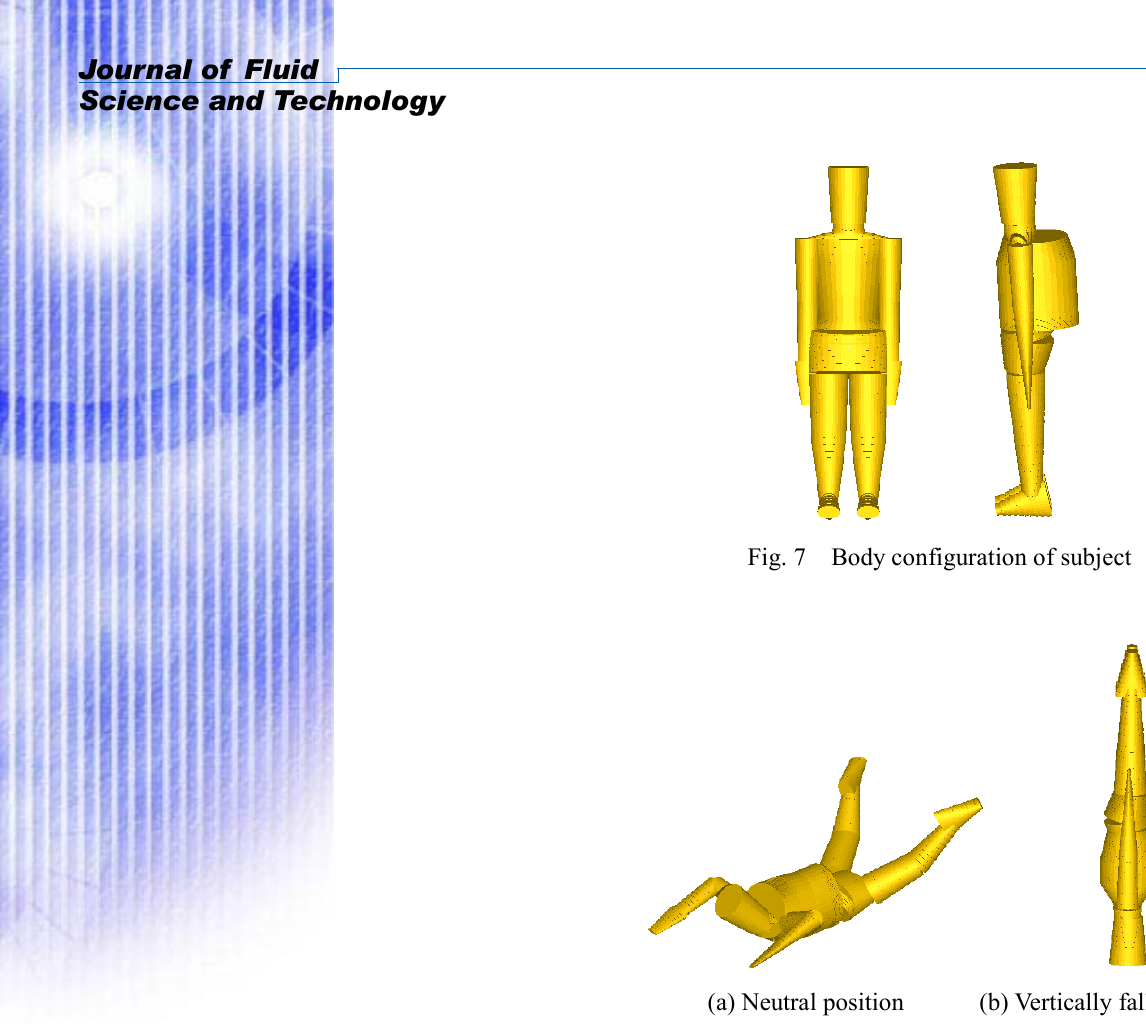
Human positions in simulation